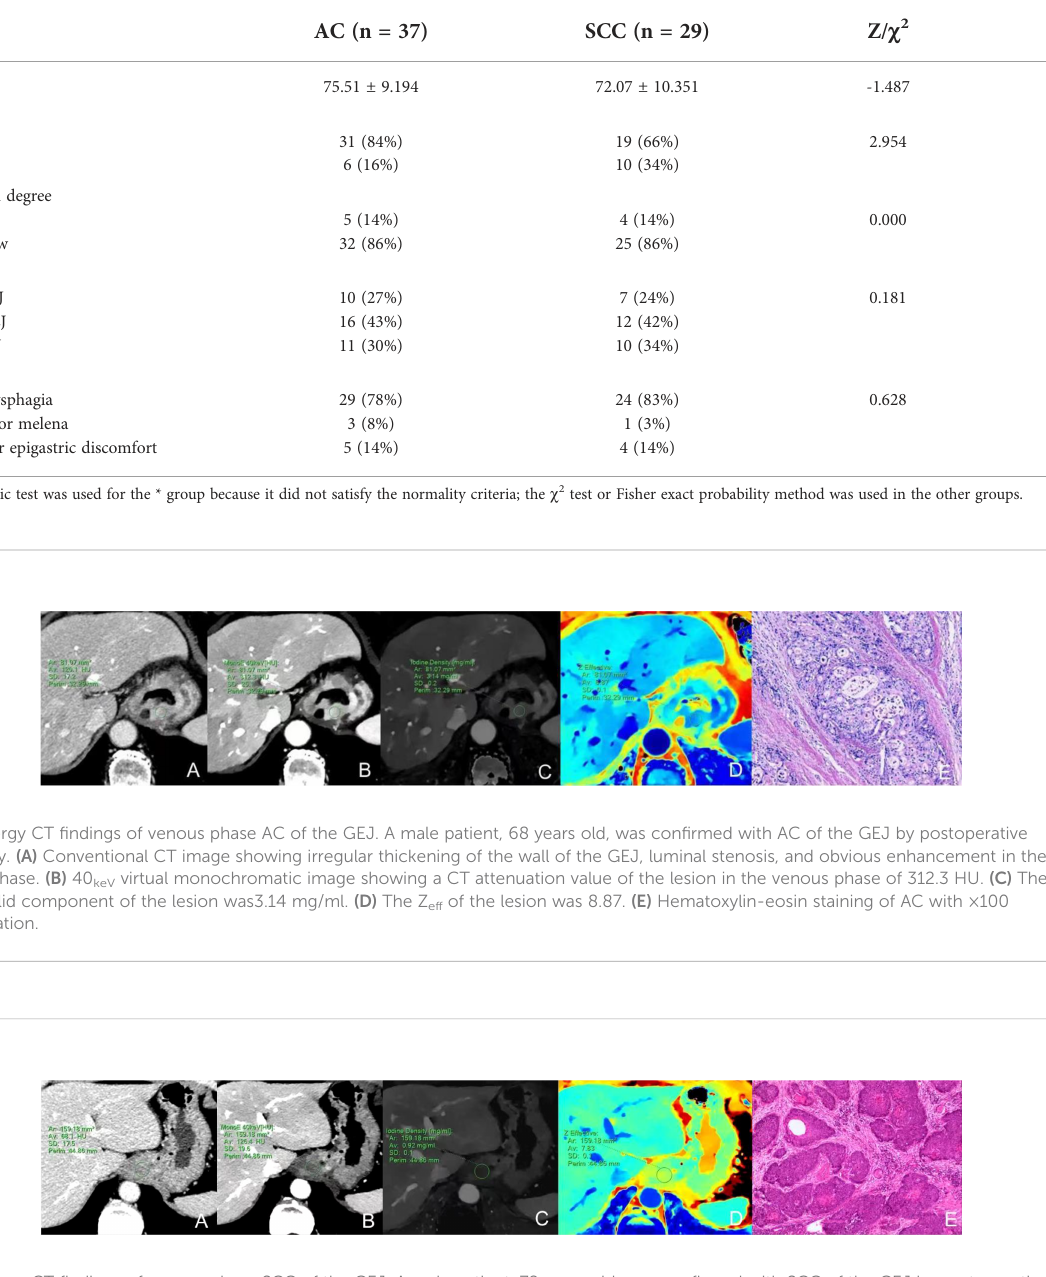
TABLE 1 Clinical data of the included